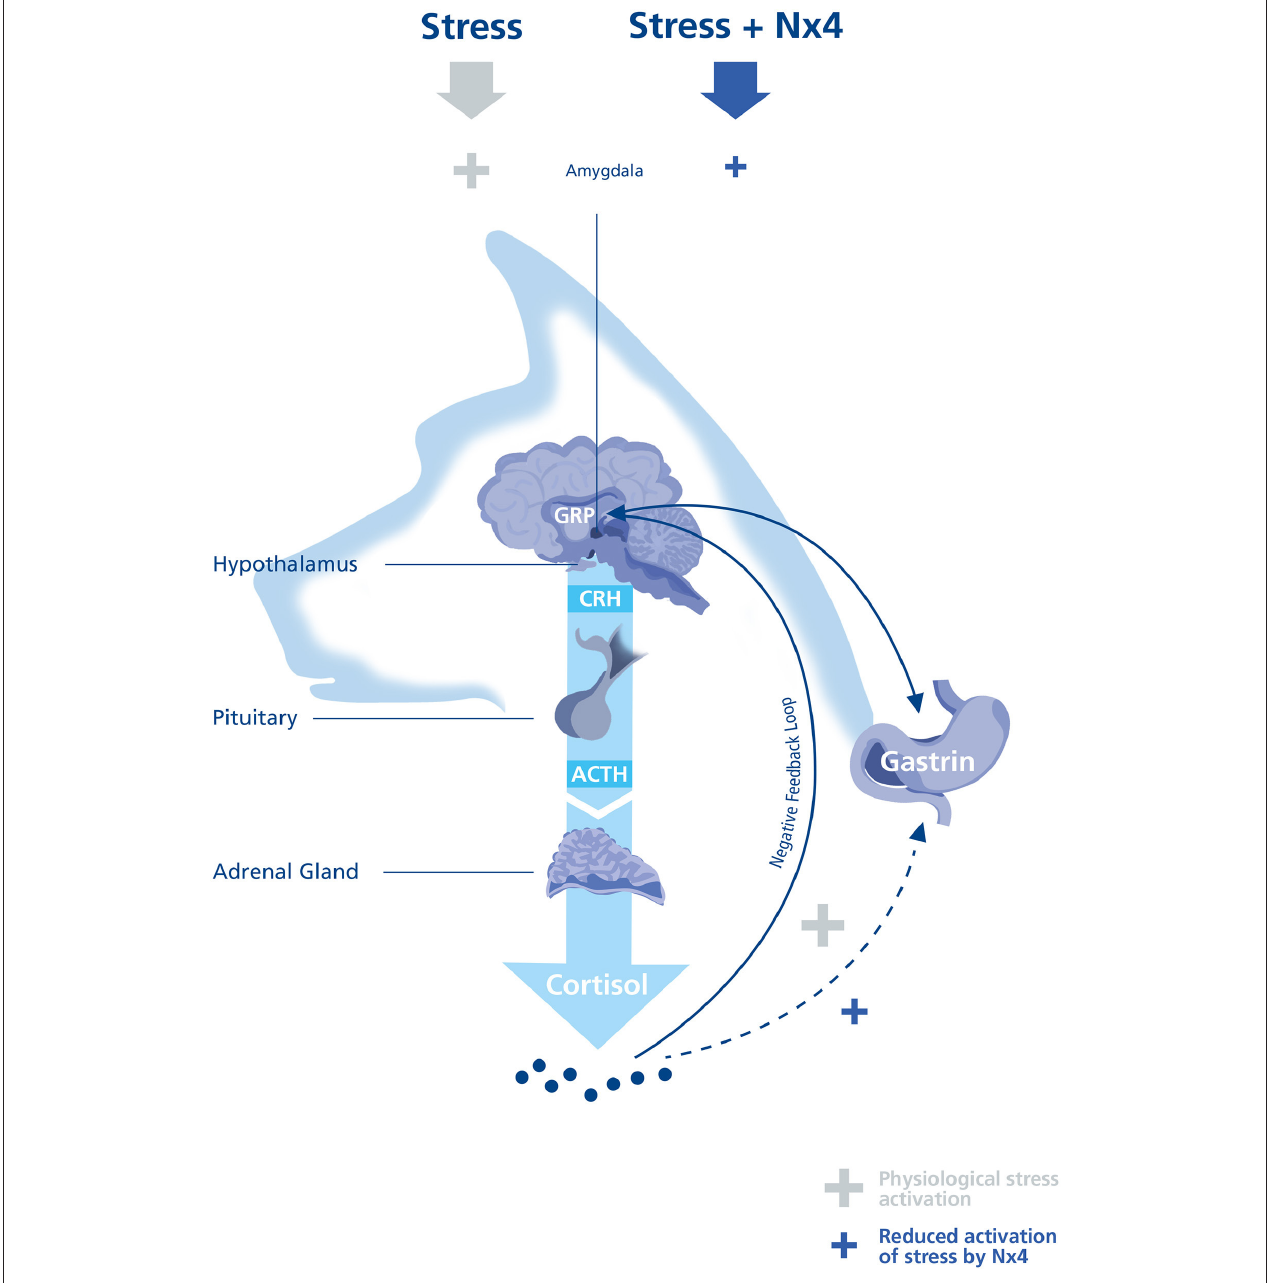
FIGURE 4 | Illustration of the HPA axis in a dog. Hypothalamic-pituitary-adrenal (HPA) axis activation is dependent on the stressor duration and intensity. A typical stress response begins with the release of Corticotropin releasing hormone (CRH) from the Hypothalamus causing adrenocorticotropic hormone (ACTH) from the pituitary to induce cortisol release. The time course of cortisol increase is depending on a combination of the activation of the negative feedback loop and by degradation of cortisol. Under physiological conditions gastrin releasing peptide (GRP) is responsible for Gastrin release to induce the gastric acid and pepsin production. Under exercise induced stress, it seems possible that Gastrin release can be activated directly or indirectly by cortisol.